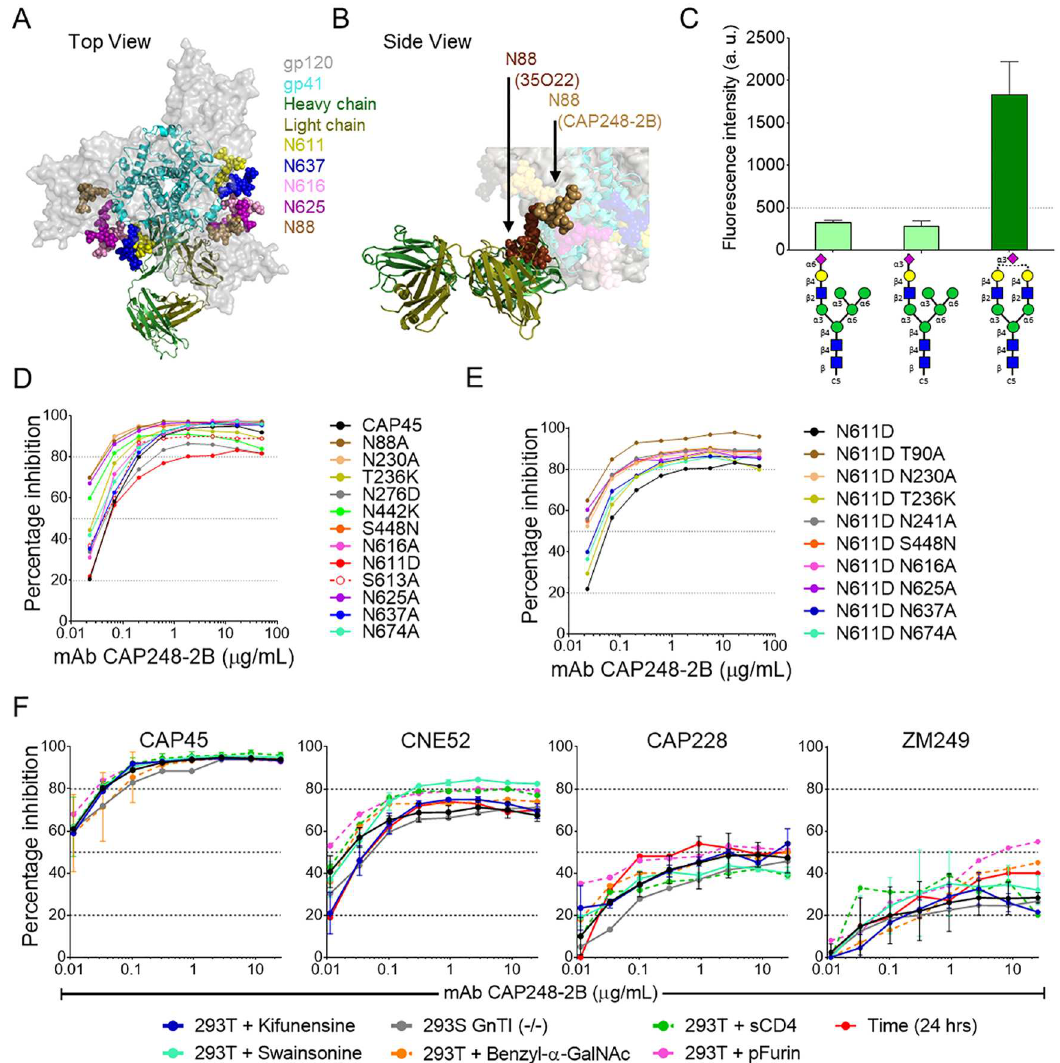
Fig 7. The CAP248-2Bepitope is proximal to Env glycans, but not affected by glycan heterogeneity. Schematic of CAP248-2B bound trimer (coloredas in Fig 4 with gp120shown in transparentsurface grey scale) includingmodelled (NAG) 2 MAN 3 basic glycans at epitopeproximalN88, N611, N616, N625, and N637 residues(coloredbrown, yellow, pink, purple, and blue respectively). Two views are shown: (A) Top view, and (B) Side view zoom. Relocation of the N88 glycan between35O22 and CAP248-2B bound states is indicated. (C) Wong glycan array data for CAP248-2B.Weak bindingwas detected for two hybrid glycans, but significantbindingof > 500 a.u. was only detected for one biantennarymono-sialylated complexN-glycan(indicatedby the glycan schema). (D) Neutralization of CAP45 by CAP248-2B when comparedto epitopeproximal glycan mutants. The S613A mutant that removedthe glycan at N611 but maintainsthe amino acid side chain propertiesis shown with red dashed lines and open circles. Percentageinhibitionwas plotted on the y-axis versus CAP248-2B antibody concentration on the x-axis. (E) Neutralization of the CAP45 N611D singlemutant, and various N611Dincludingdoubleglycan mutants, plotted as in D. (F) Neutralization of heterologous tier-2 strains CAP45, CNE52, CAP228, and ZM249 when grown normally(black lines), with co-transfected furin (dashedpink lines), or in the presence of kifunensine (blue lines), swainsonine (cyan lines), and an O-linked glycosylationinhibitor (dashedorangelines), or in a GnTI deficient cell line (grey lines). Neutralization was also assessedin the presenceof sCD4 at predetermined IC 40 concentrations for each virus (dashedgreen lines), or after a 24 hour virus-target cell incubation period (red lines). Graphs are plotted as in